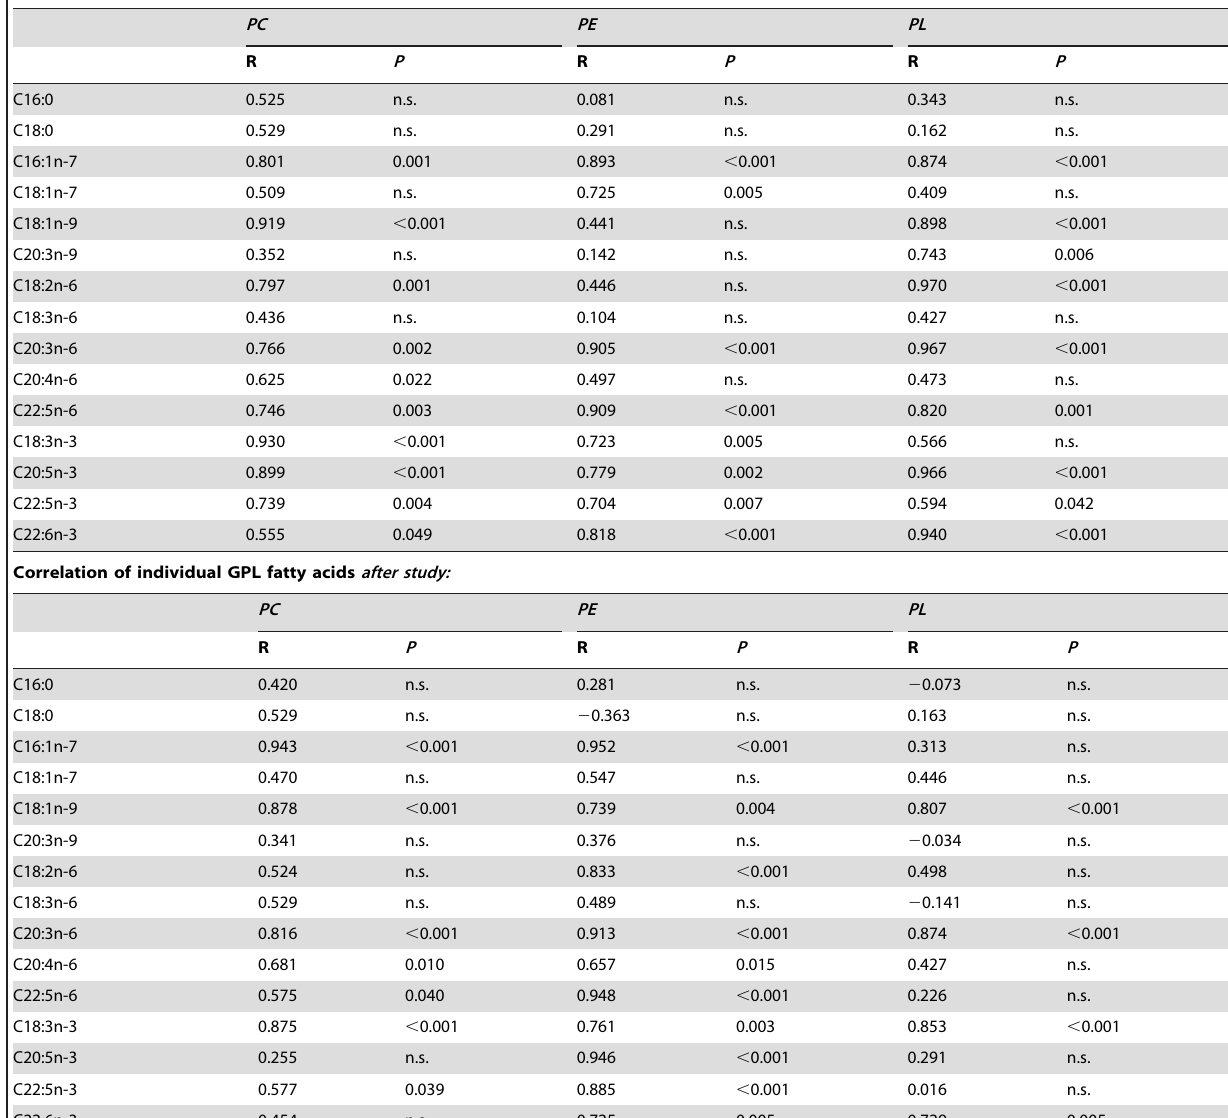
Correlation of individual GPL fatty acids beforestudy: PC PE PL